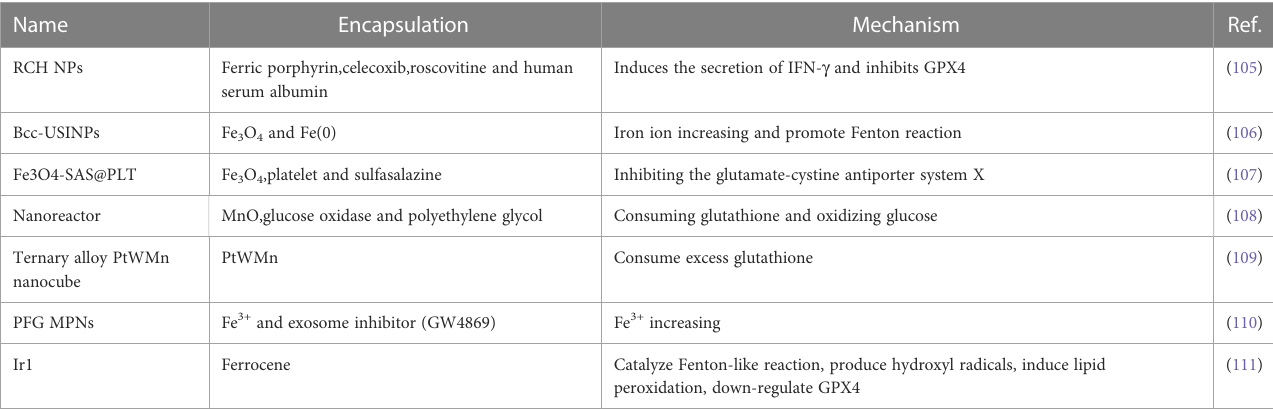
TABLE 1 Recently developed nanoparticles or complexes related to